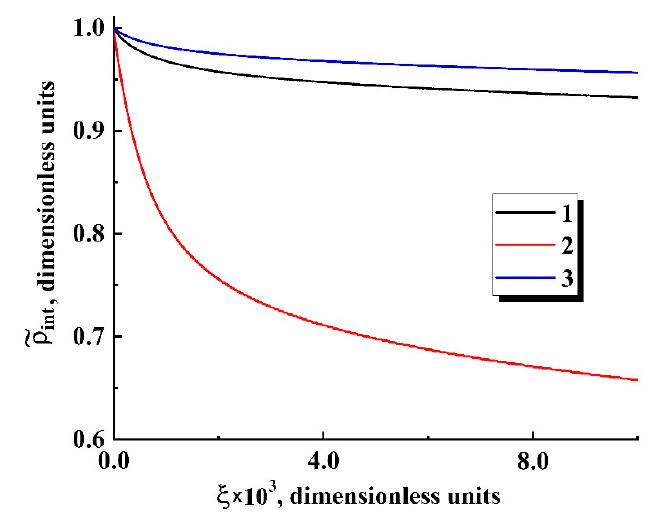
Figure 11. Jumps of the normalized carbon dioxide density in expanding embryos during the transient stage (results of modeling). T = 310 K; Ξ = 0.001. 1— P int,0 = 4.0 MPa; 2— P int,0 = 8.3 MPa; 3— P int,0 = 10.0